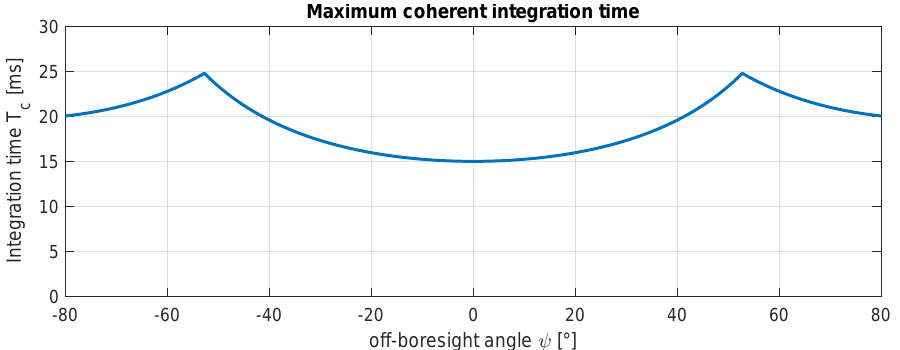
Figure 4. Maximum coherent integration time if SAR processing is not implemented (unfocused SAR), as obtained according to (12). Reference parameters: f 0 = 77 GHz, v ego = 10 m/s, B = 1 GHz, R = 10